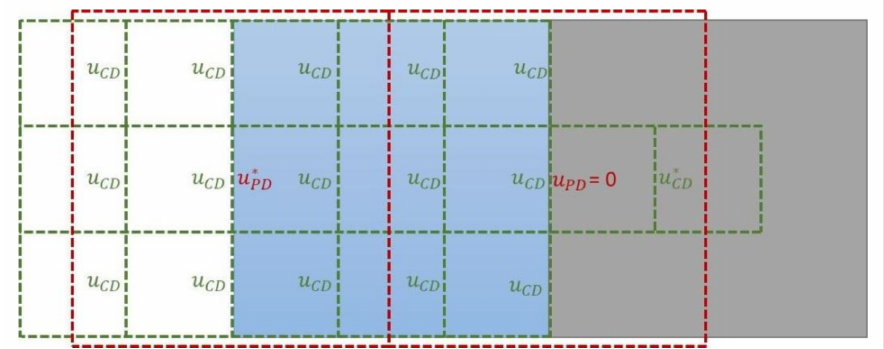
Figure 2. Schematic domain (dashed green squares) nested in the PCOMS domain (white, blue, and grey boxes). The lateral discharge is computed using the schematic domain cell velocities u ∗ located inside the land cells of the regional domain (grey), and the discharge is implemented in the first regional domain cell adjacent to the land cell (blue square). The momentum produced by the discharge velocity is added to regional domain in the face of the cell opposed to the land cell u ∗ which is located in the centre of the u velocity cell (red dashed line). For a more detailed description of these computations, the reader is referred to